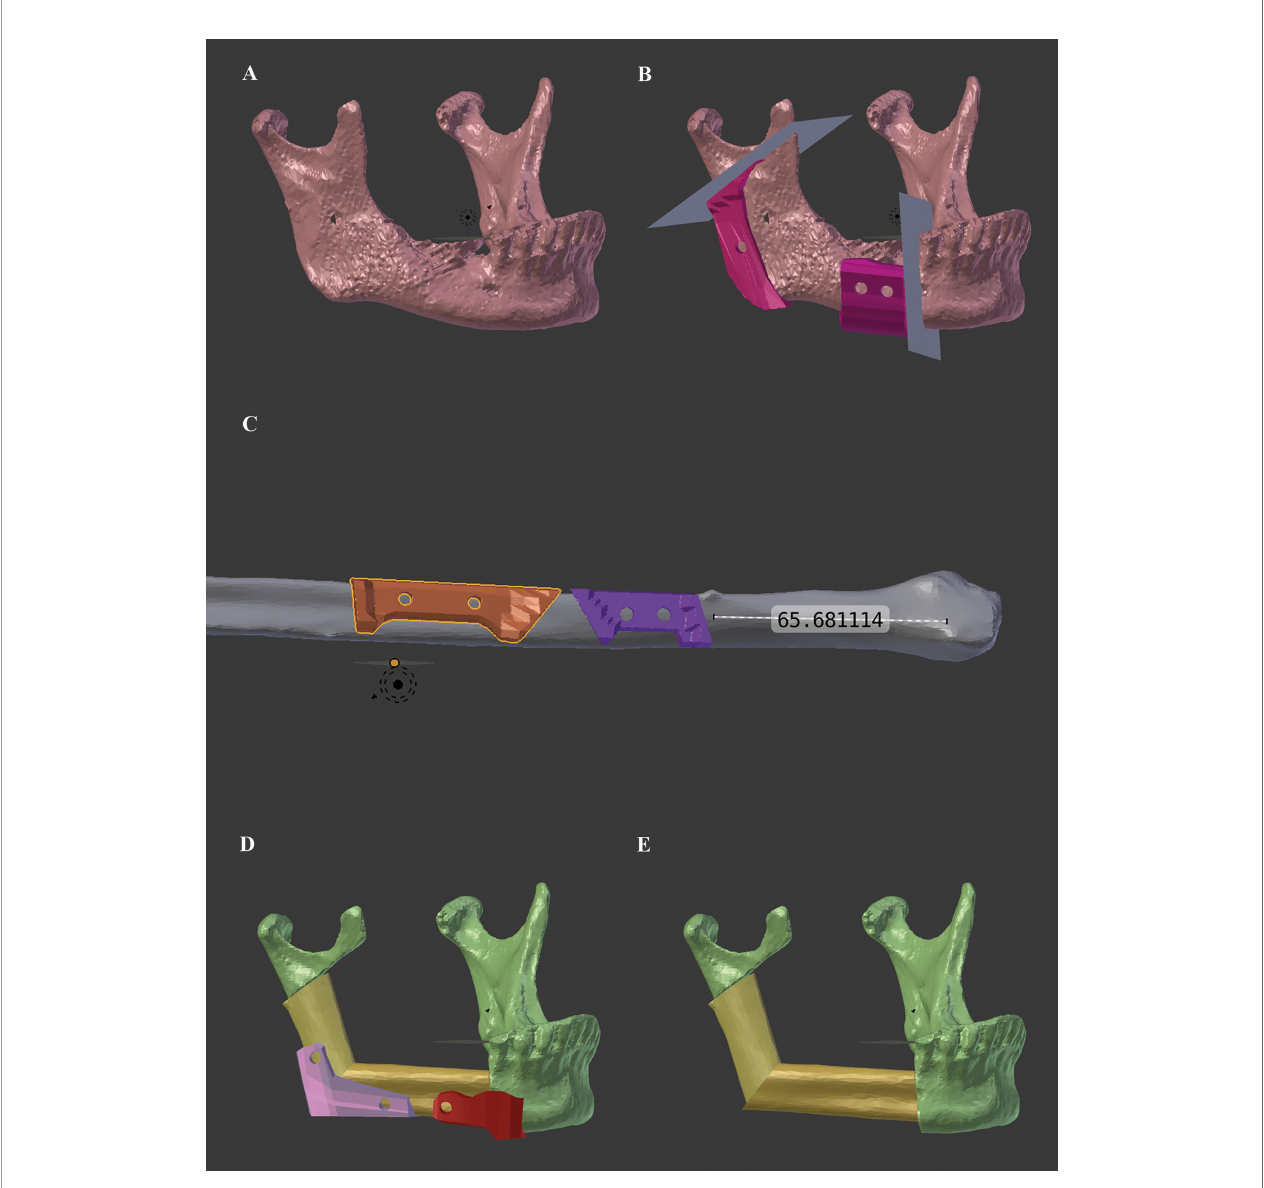
FIGURE 2 | Work fl ow for in-house Blender-based (Blender ® Version 2.79; Blender Foundation and Institute; Amsterdam, Netherlands) planning and design of corresponding mandibular and fi bular cutting guides and repositioning aids for mandibular reconstruction with the free fi bula fl ap. (A) preoperative mandibular situation, (B) simulated resection planes and designed mandibular cutting guides, (C) corresponding fi bular cutting guides, (D) repositioning aids (at angle and neomandibular/mandibula body junction), and (E) fi nal virtually reconstructed